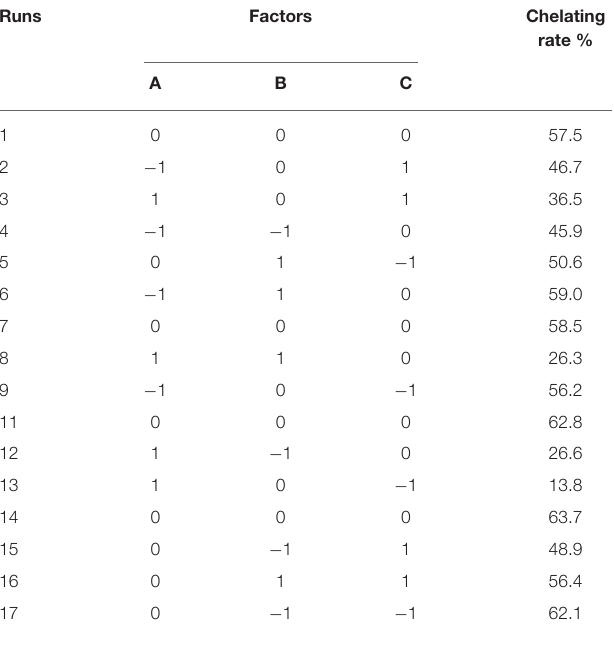
TABLE 3 | Central composition test design and results. Runs